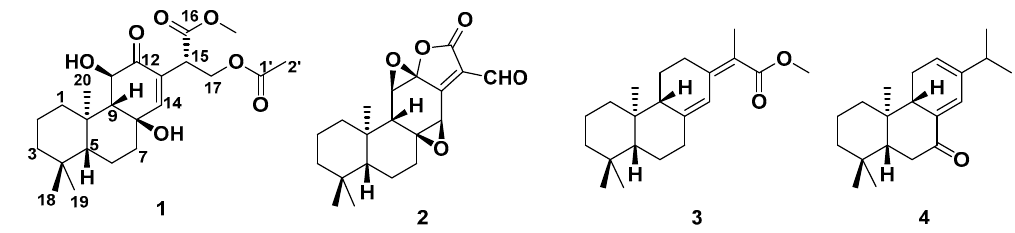
Figure 1. The structures of compounds 1 – 4 .